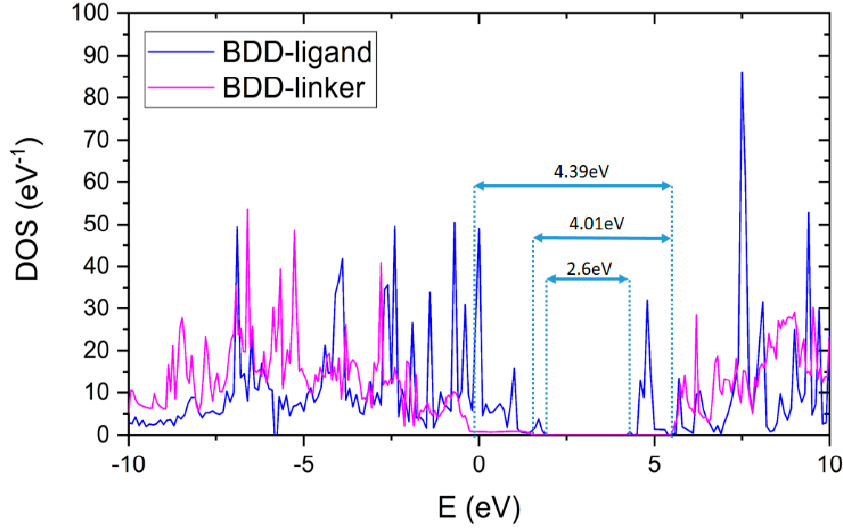
Figure 6. The density of states spectra for BDDE-H-ABA and BDD-H-ABA-C3M with additionally added BDD band gap for change comparison. added BDD band gap for change